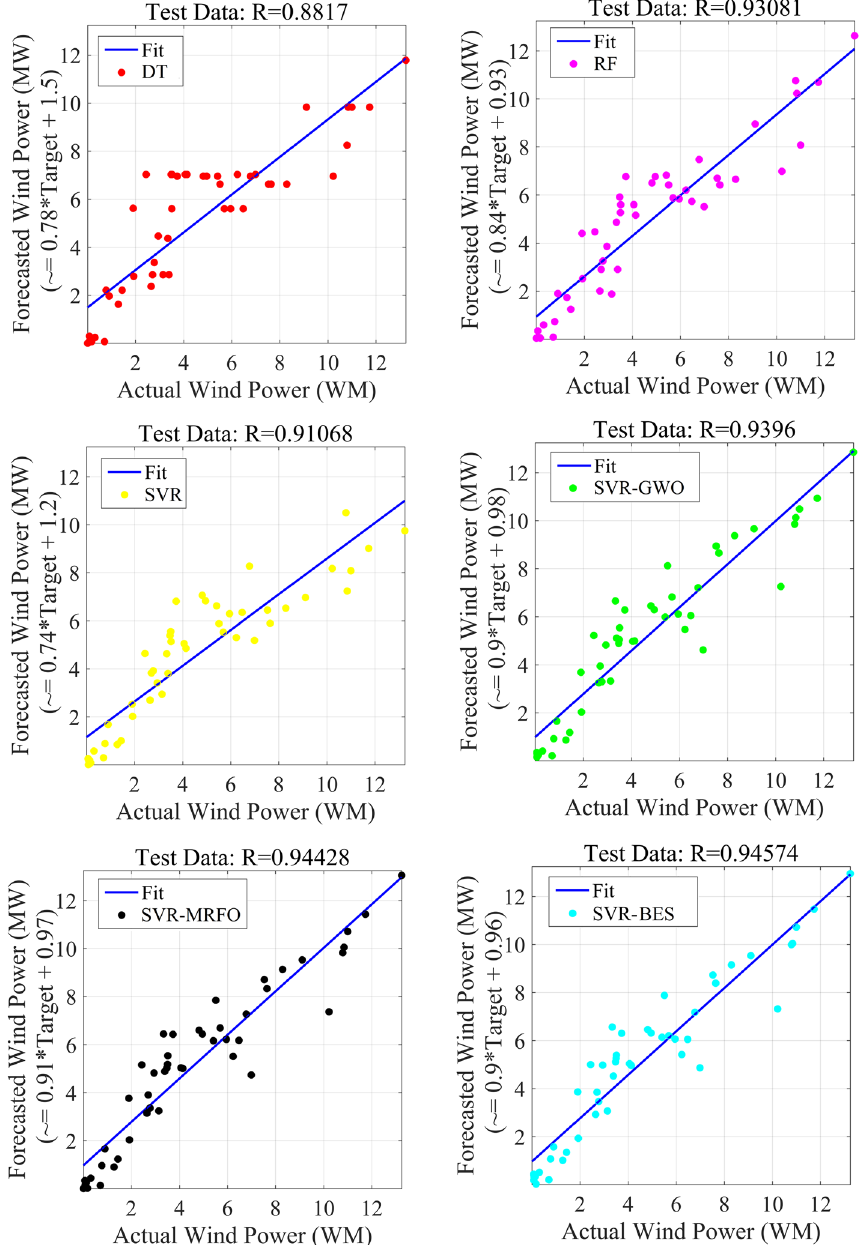
Fig. 8 Scatter plots of forecasted wind power for 48